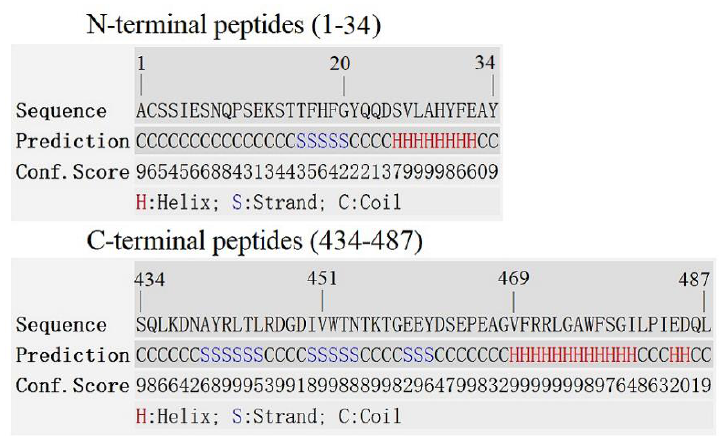
Figure 2. Predicted secondary structures of the N- and C-terminal amino acid sequences of PLD investigated in the present study, obtained using the I-TASSER server. To ensure the accuracy of the results, each sequence was analyzed using two additional online tools: Proteinprediction and SSPro. The three types of analysis yielded similar results. The secondary structures here presented are those with the highest confidence scores (Conf.Score). The confidence scores range from 0 to 9, which correspond, respectively, to the lowest and the highest confidence levels. H, Helix; S, strand or β-sheet; C, coil. Table 1. Analysis of the amino acid content of the N- and C-terminal sequences of PLD from V. parahaemolyticus. Amino Acids Number